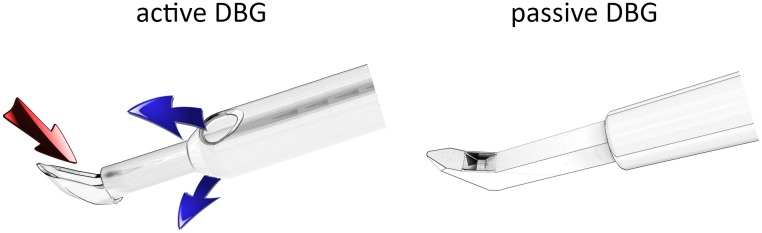
Active and passive dual blade goniectome.The active dual blade goniectome (active DBG, left [7,8]) has two irrigation ports that maintain the chamber (blue arrows). The trabecular meshwork is put under stretch by an angle shaped ramp and excised by a left and a right blade. The cut trabecular meshwork strip, blood and debris are aspirated into the tip (red arrow). The passive dual blade goniectome (passive DBG, right [6]) requires viscoelastic to maintain the anterior chamber. It also puts the trabecular meshwork under stretch by an angle shaped ramp and cuts the trabecular meshwork with a left and a right blade. The trabecular meshwork strip can be left in the eye or amputated and extracted with microforceps.